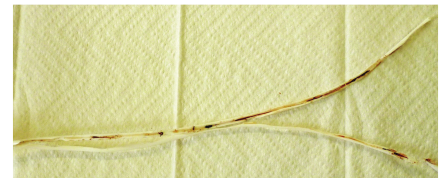
Figure 1: Visible adhesions to the catheter wall.